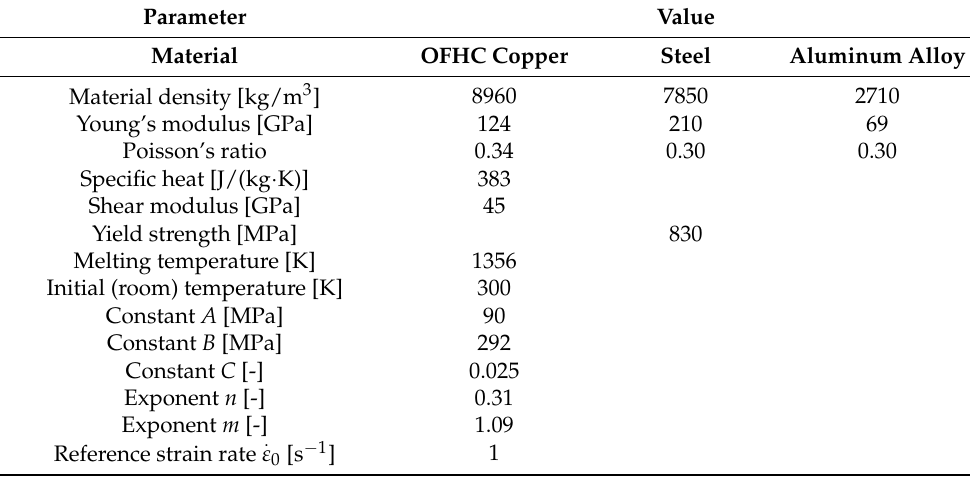
Table 7. Constitutive model parameters applied during simulations.